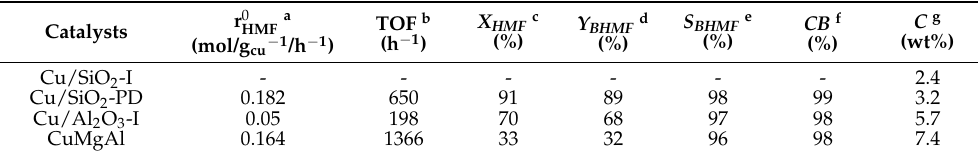
Table 3. Liquid-phase HMF hydrogenation over Cu-based catalysts at 393 K and 15 bar H 2 pressure (W Cat. = 0.5 g, V THF = 150 mL of